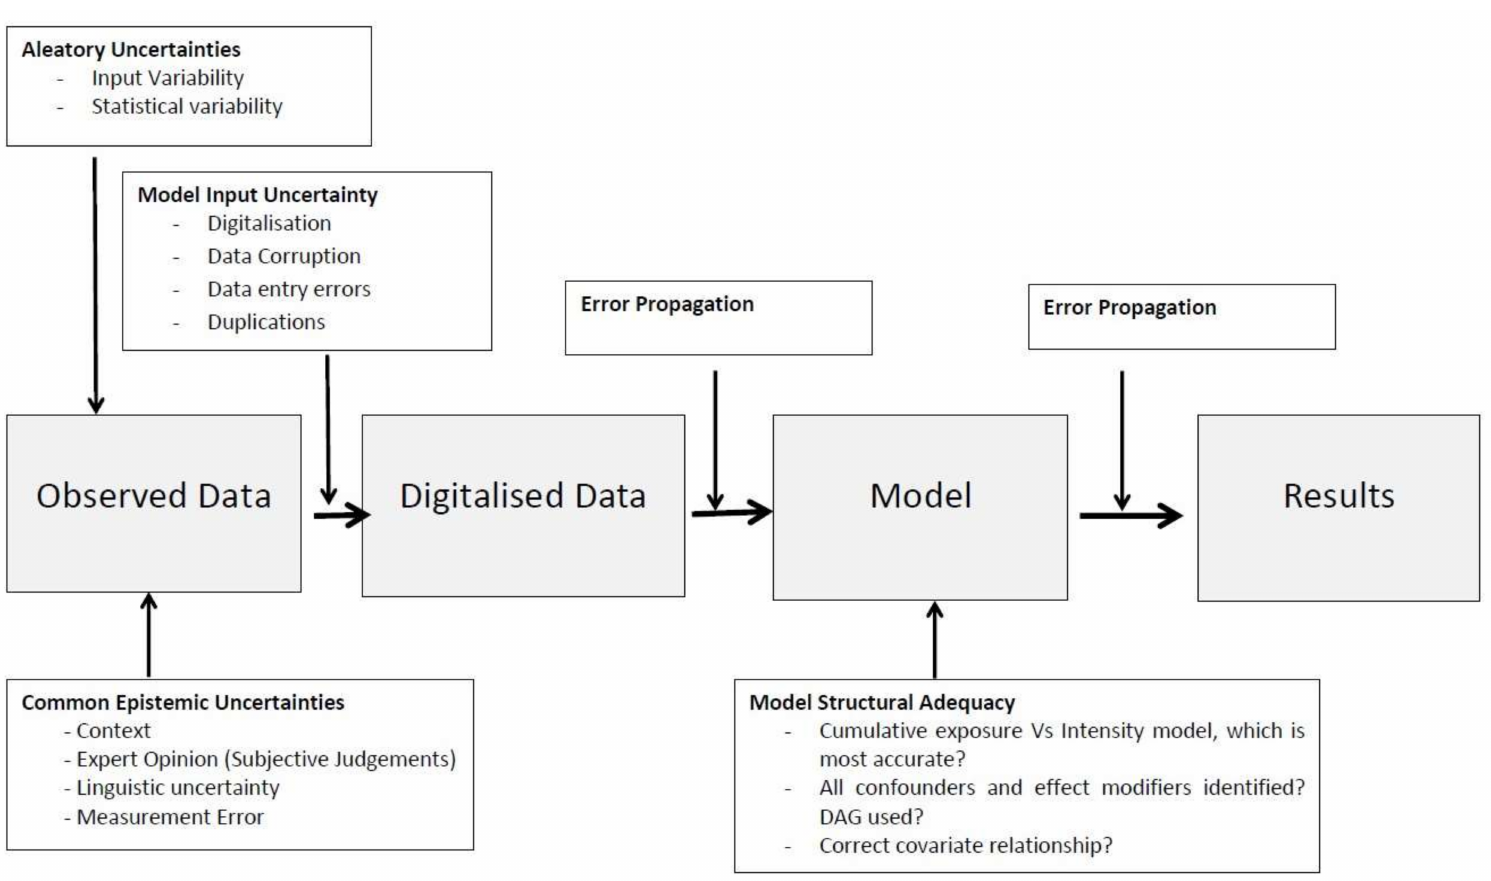
Figure 4. Visual representation of the sources of uncertainty found throughout the modelling process of RF-EMR and Cognitive function. Sources of uncertainty can enter the modelling process at different points and can be due to known and unknown sources. (Adapted from Robinson et al.